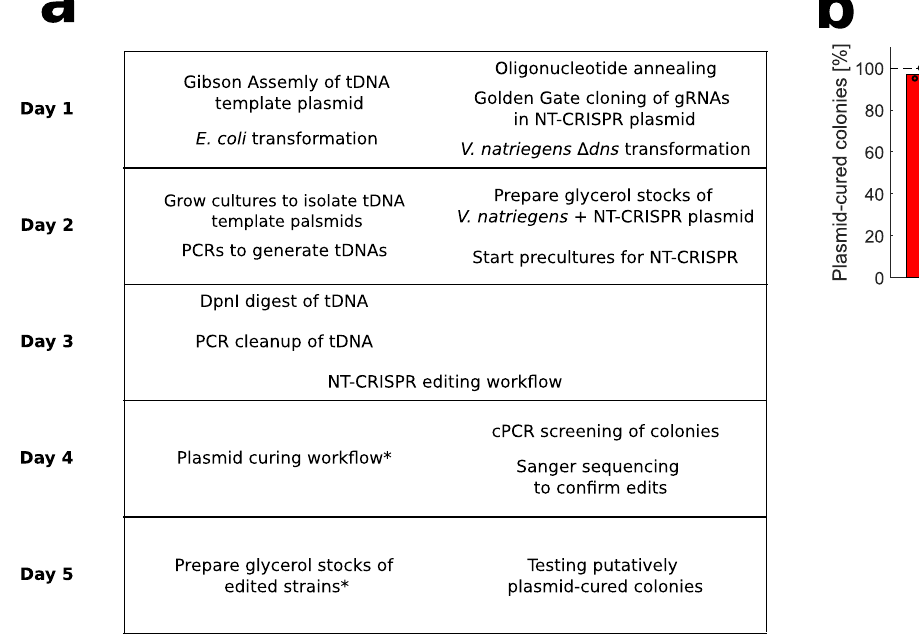
Fig. 6 Timetable of full NT-CRISPR procedure and plasmid curing. a Under ideal conditions, eight to ten hours per day are suf fi cient to go from preparation of tDNAs and cloning of gRNAs into the NT-CRISPR plasmid to a plasmid-cured edited strain in one week (Monday to Friday). Steps marked with asterisks (veri fi ction of edits by cPCR and Sanger sequencing, as well as the con fi rmation of plasmid loss after plasmid curing) can be performed in parallel with the next steps. To increase success rate, multiple colonies can be used for the consecutive step and later be discarded if veri fi cation yields negative results. Details for all individual steps can be found in the Method sections. b Plasmid curing ef fi ciency. The work fl ow was performed as described in the Method sections with colonies resulting from deletion of wbfF with NT-CRISPR. n = 20 replicates, representing fi ve wbfF deleted colonies of two transformants of the NT-CRISPR plasmid (circle or triangle) and two independent experiments ( fi lled or open symbols). The bar shows the mean of all replicates and the error bar indicates the standard deviation of the mean. The reported fraction of plasmid-cured colonies is the result of streaking 20 colonies of each replicate on LBv2 agar plates with and without chloramphenicol. Colonies resulting in growth on LBv2 agar plates without but not with chloramphenicol were considered to consist of cells that have lost the NT-CRISPR plasmid. Fotos of streaked colonies are shown in Supplementary Fig.